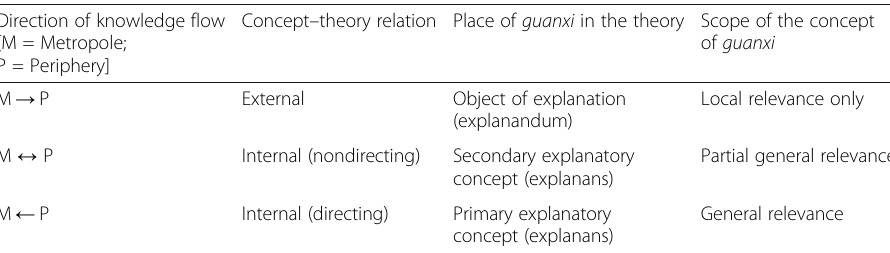
Table 1 Knowledge flow and theory development Direction of knowledge flow [M =